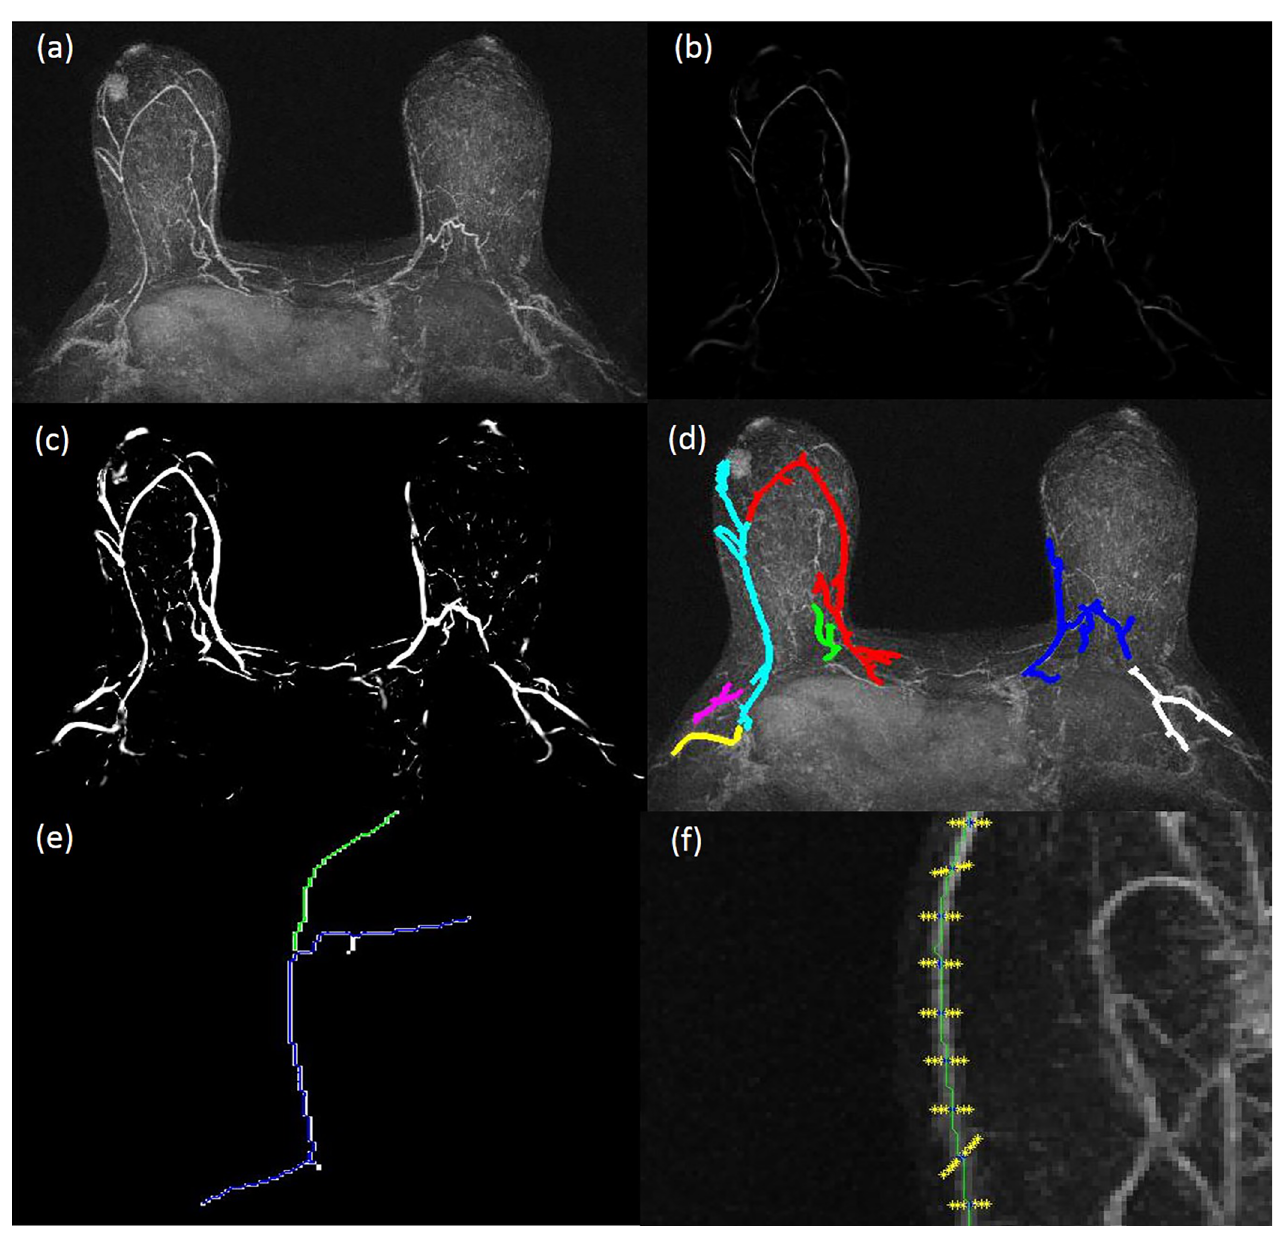
Fig 1. Semiautomatic vascular map extraction: (a) MIP obtained subtracting the first post-contrast sequence from pre-contrast sequence; (b) multiscale vessel enhancement filtering; (c) optimal contrast image after global histogram equalization; and (d) skeleton with extracted vessel in different colors (color figure online); (e) Semiautomatic vessel length and diameter measure: a vessel tracking; (f) normal segments to vessel direction.